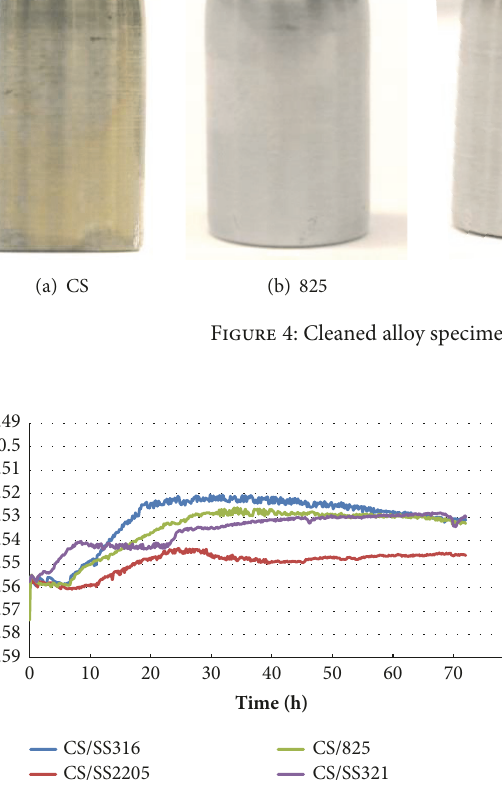
Figure 5: Average potential versus time for all galvanic couples in stagnant deaerated 3.5% ABS at 60 ∘ C.